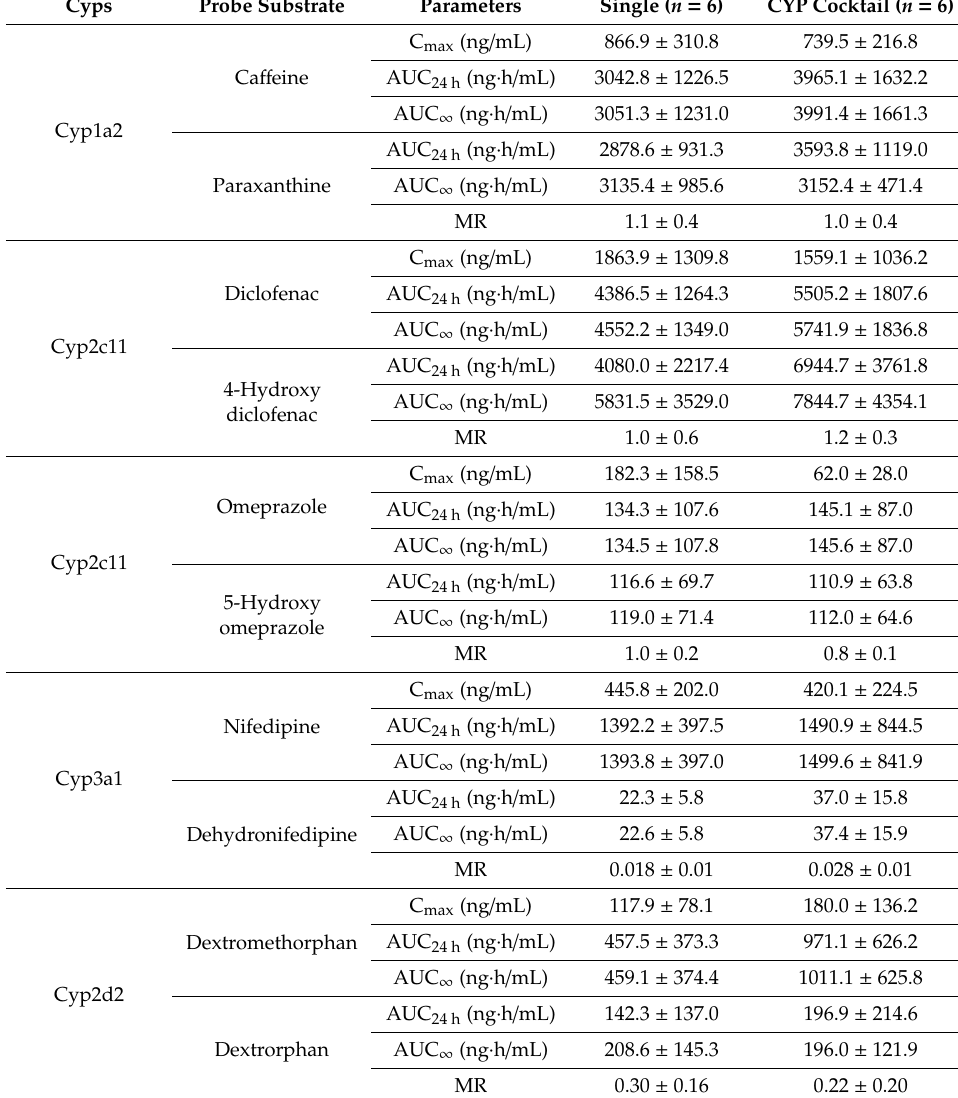
Table 5. The comparison of pharmacokinetic parameters between single and CYP cocktail